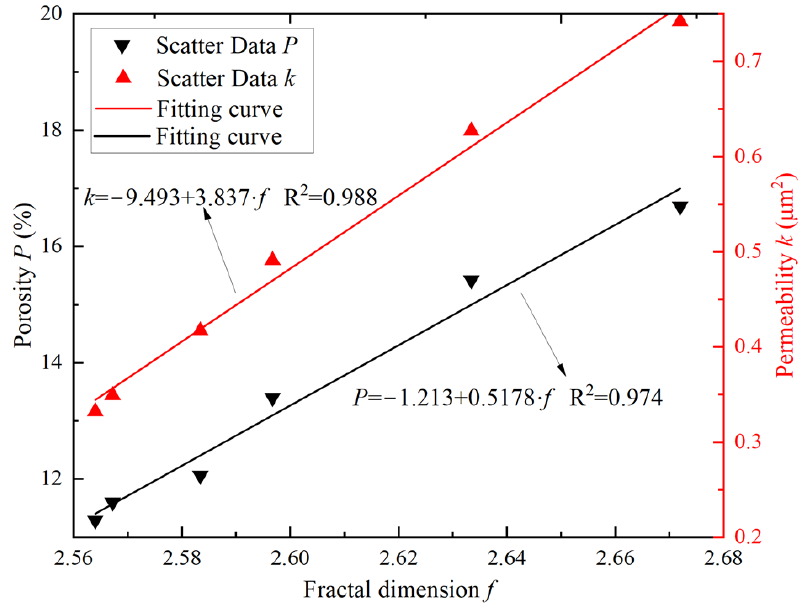
Figure 12. Changes in porosity and permeability with fractal dimension of the sample under the F–T action. From Figure 12, the porosity and permeability of the samples are positively correlated with the fractal dimension. This is consistent with the variation of porosity,